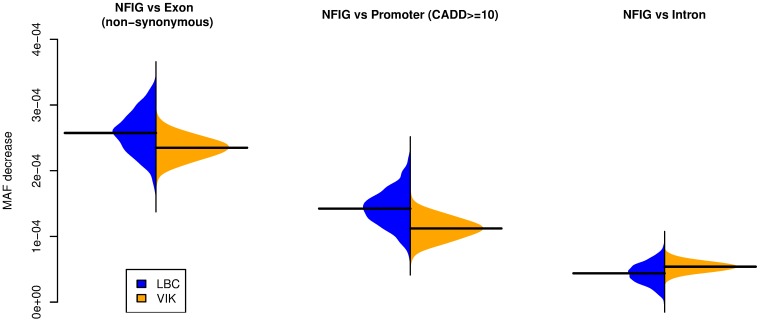
Allelic shift bias (ASB) suggests loss of constraint at VIKING exonic and promoter regions.MAF shifts for very rare SNPs (MAFNFE ≤ 1%) between non-functional intergenic regions (NFIG), considered as baseline, and non-synonymous SNPs in exonic regions, SNPs with CADD score ≥ 10 in promoter regions and intronic SNPs, for each of the cohorts. These MAF differences are calculated using 1000 randomly selected LBC subsets of size 269 individuals (matching the VIKING size; with replacement) and considering only variants shared between the VIKING and the currently evaluated LBC subset, for which we computed the cohorts’ mean MAF in exonic, promoter, intronic and non-functional intergenic regions (see S10 Fig). Black horizontal lines represent mean values. The differences in MAF shifts in the two cohorts are statically significant for all three comparisons (p < 2.2x10-16, one-sided Wilcoxon rank sum test).